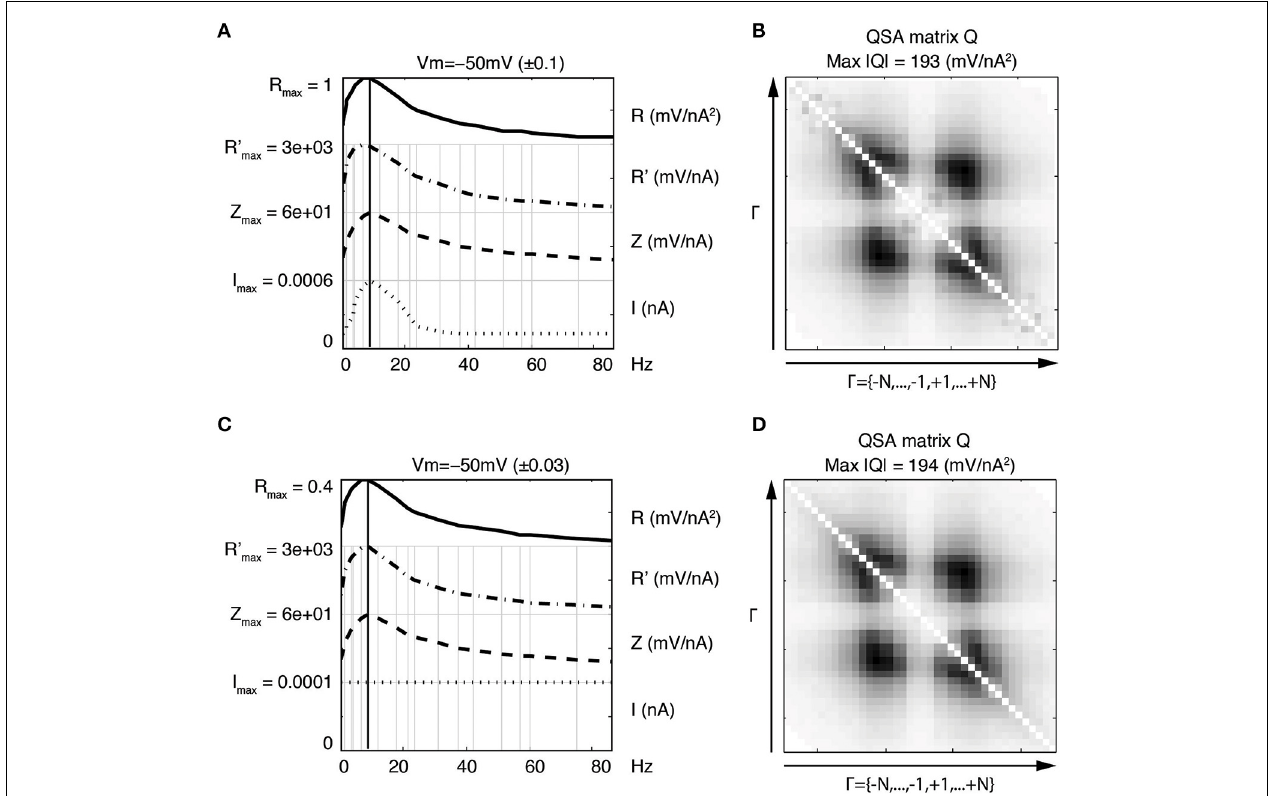
FIGURE 9 | Equivalence of nonlinear responses for different stimulation profiles at very small amplitudes. Upper row (A,B) Gaussian-like window applied to the stimulation Fourier components. Lower row (C,D) constant